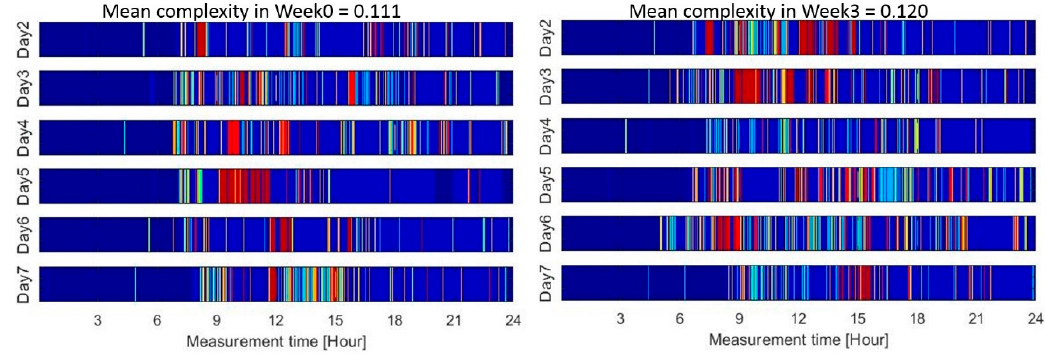
Figure 2. Barcode and mean complexity of one-week PA time series of Week0 ( left ) and Week3 ( right ) in one participant.